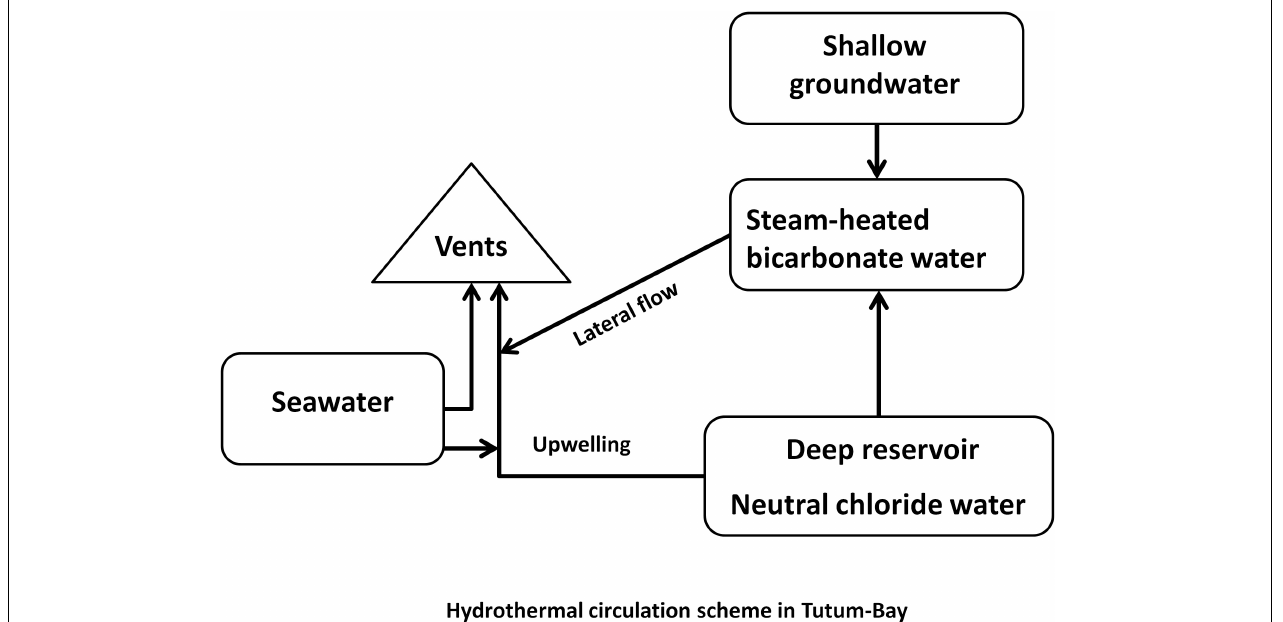
FIGURE 4 | Simplified flow of the fluids in the vents in Tutum Bay (data from Pichler et al., 1999).